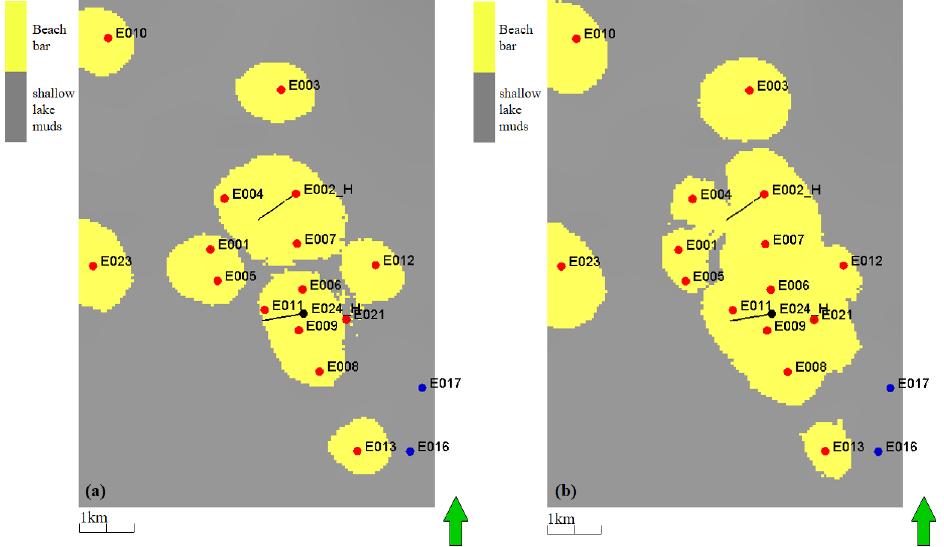
Figure 18. The facies model of SC2 layer in E area of Xinjiang Oilfield established by the UCSC method. ( a ) Realization1; ( b ) Realization2.